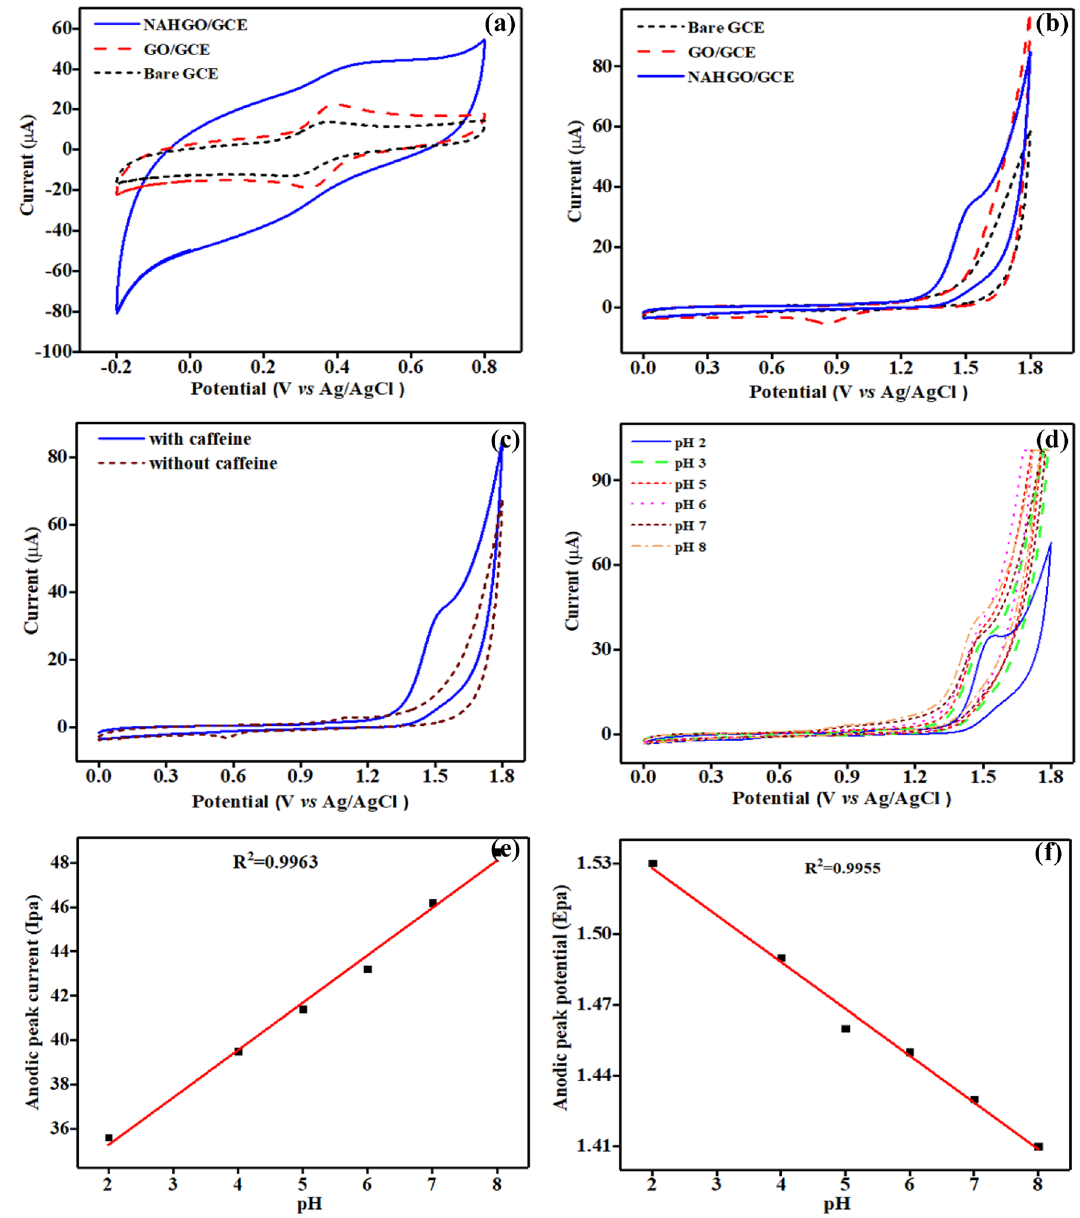
Figure 3. Cyclic voltammograms of the bare GCE, GO, and NAHGO ( a ) in the presence of 0.001 M K 4 Fe(CN) 6 in 0.1 M KCl, ( b ) at pH 2 with 100 × 10 –6 M of caffeine at a scan rate of 50 mV s −1 , Cyclic voltammograms of NAHGO ( c ) with and without caffeine, ( d ) at pH values of 2, 3, 5, 6, 7, 8, in 100 × 10 –6 M of caffeine, at a scan rate of 50 mVs −1 , Calibration plot of ( e ) pH vs. anodic current (Ipa), and ( f ) pH vs. anodic peak potential